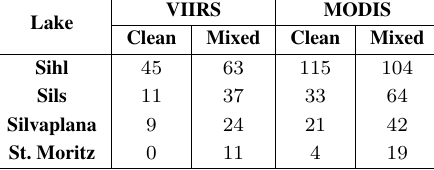
Table 6: The number of clean and mixed pixels per acquisition per lake, for VIIRS ( 375 m GSD) and MODIS ( 250 m GSD).